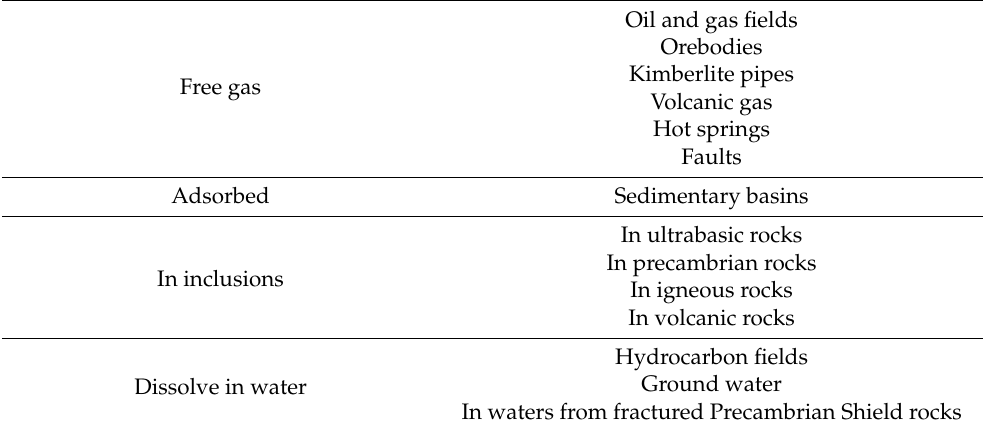
Oil and gas fields Orebodies Kimberlite pipes